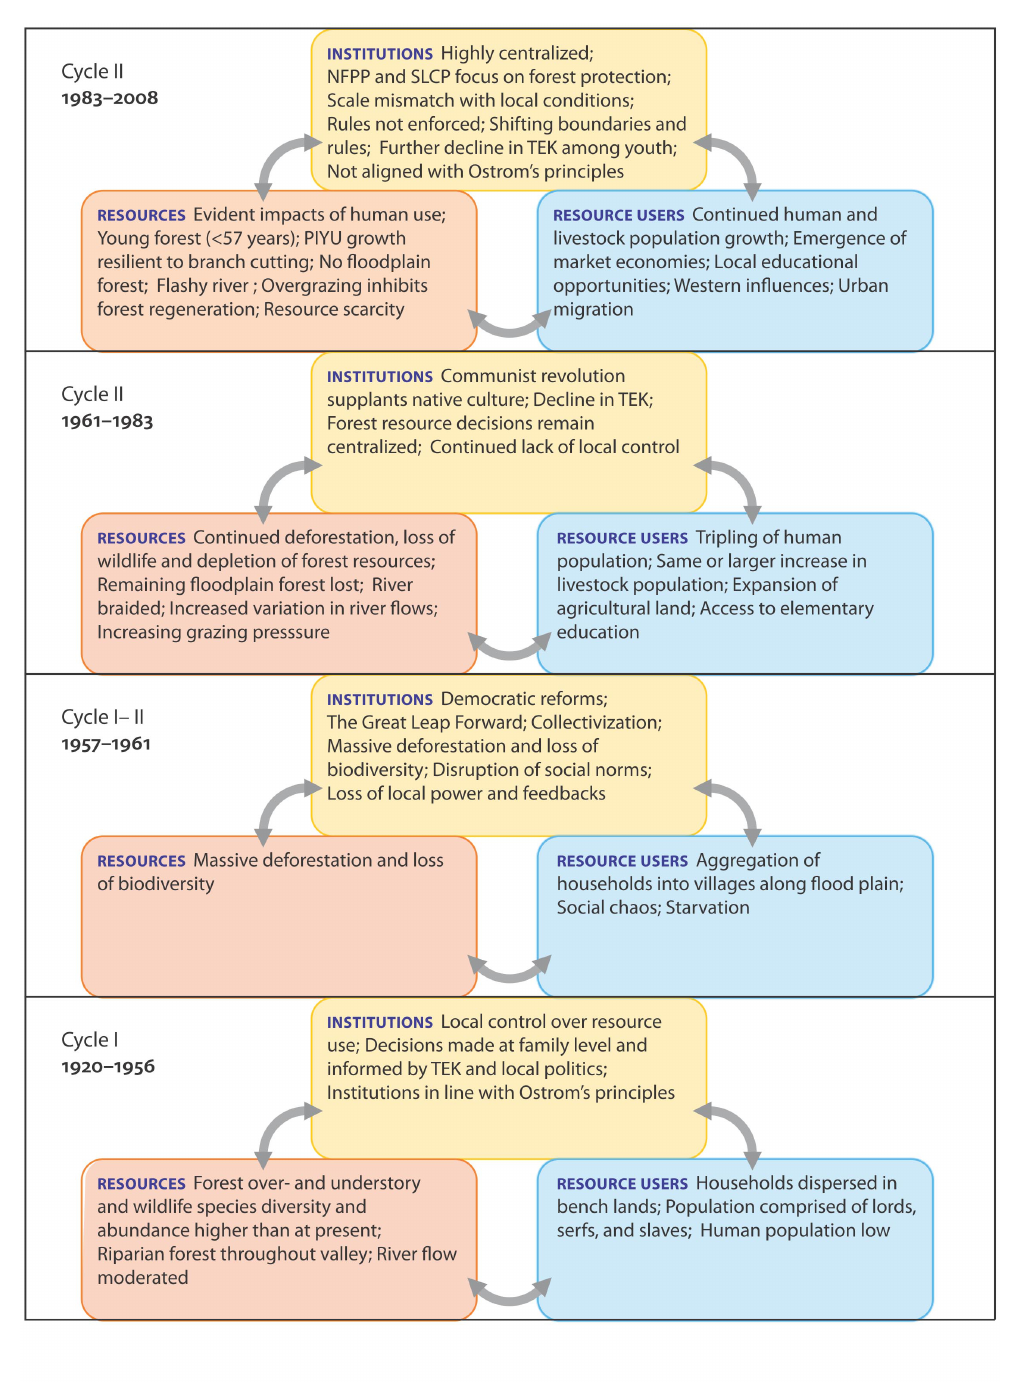
Fig. 8. A summary of key changes in institutions, resources, and resource users within the Upper Baiwu watershed across two adaptive cycles